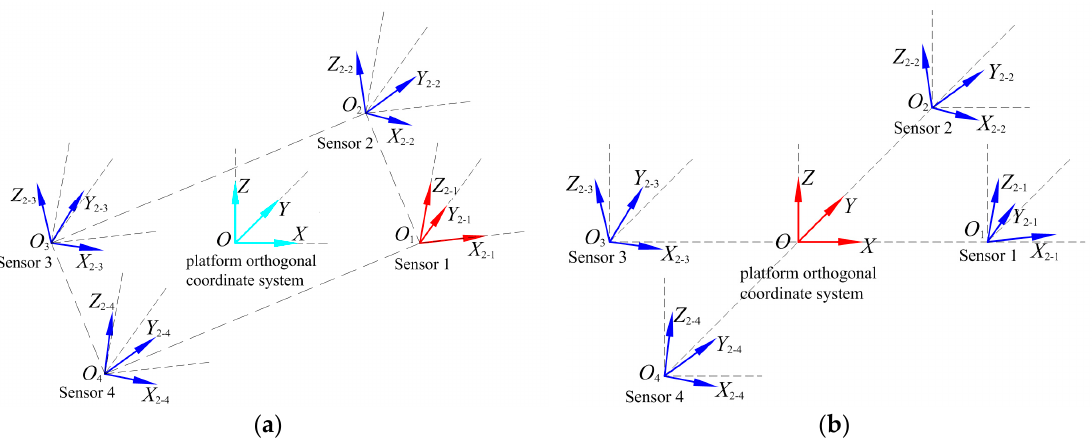
Figure 3. Comparison of misalignment error calibration reference system selection methods: ( a ) calibration method of Pang et al.; ( b ) calibration method of this paper. The ideal output of the sensors can be converted to the output of O-XYZ by rotating around three orthogonal axes. We define α as the roll angle of the rotation around the X- axis, β as the pitch angle of the rotation around the Y- axis, and γ as the yaw angle of the rotation around the Z- axis. Considering that only the roll, pitch, and yaw angles are present, we represent the roll conversion output as B α , the pitch conversion output as B β , and the yaw conversion output as B γ , as given by: